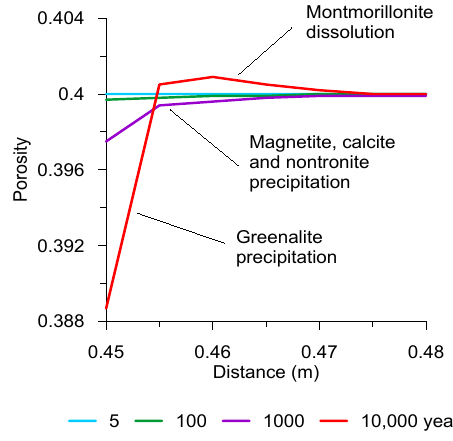
Figure 4. Porosity against length for the reference model (r c = 2 µ m y − 1 ). The interface between steel and bentonite is at 0.45 m. Results at 5, 100, 1000, and 10,000 years of interaction are